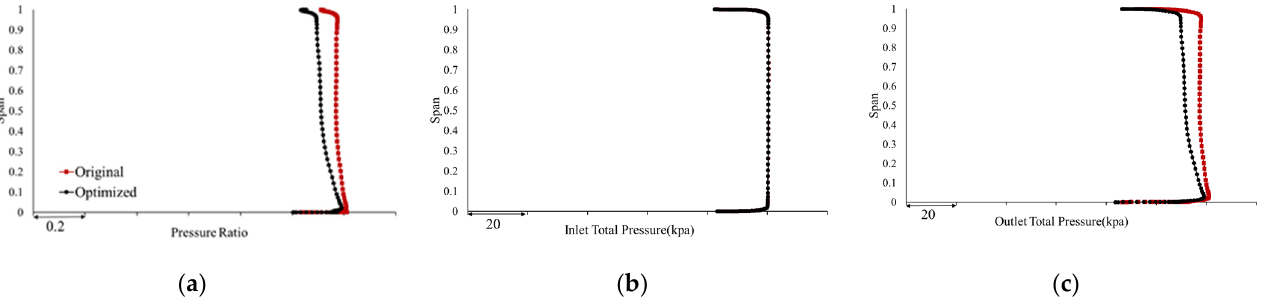
Figure 14. Efficiency spanwise distribution. ( a ) Efficiency of R1; ( b ) loss of S1; ( c ) efficiency of R2; ( d ) loss of S2.